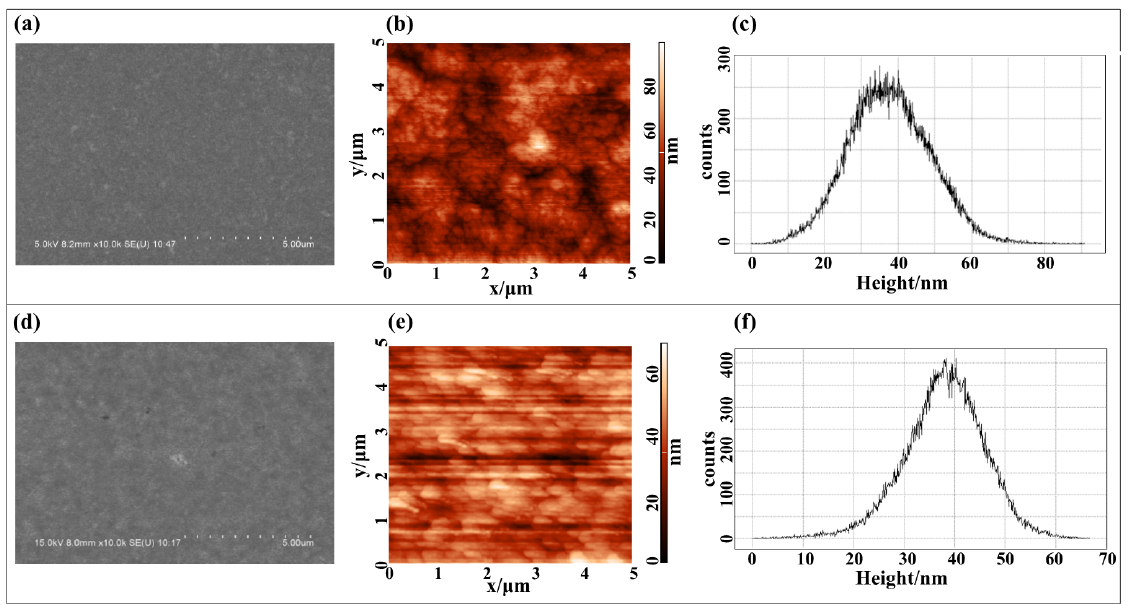
Figure 4. The surface of the electrode before and after etching with protective layer. SEM images before etching ( a ) and after etching ( d ); AFM images before etching ( b ) and after etching ( e ); The counts of the height of the sampling point before etching, 𝑅𝑎 = 8.9 nm ( c ) and after etching, 𝑅𝑎 = 6.2 nm ( f ).